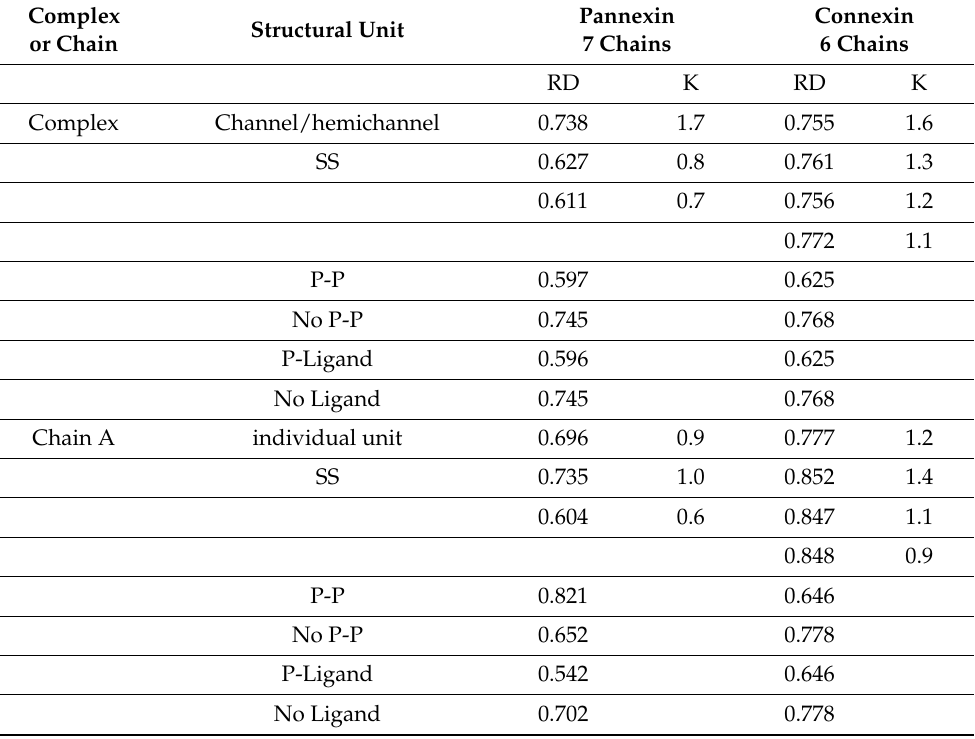
Table 1. The summary of the values of parameters RD and K for the selected structural units. P-P— the residues involved in cross-chain interactions, No P-P—the remainder of the protein excluding the residues involved in P-P, SS—disulfide bonds. P-Ligand—status or residues engaged in ligand interaction, No P-Ligand—the status of the molecule with residues engaged in interaction with ligand eliminated from the calculation. The results are shown for complete complexes treated as structural units (3D Gauss function spanned on the complete complexes as well as for single-chain treated as an individual structural unit—the 3D Gauss function spanned on a single